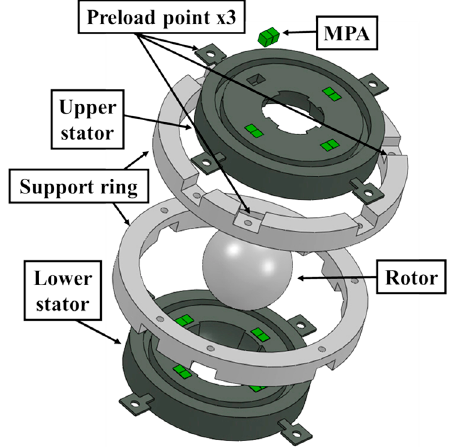
Figure 7. Component parts of sandwich structure used in the new stator.